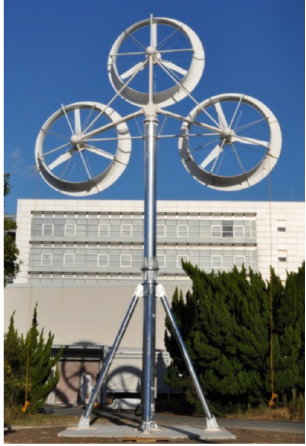
Fig. 4. 10 kW multi rotor Wind lens turbine system (3 kW (cid:1) 3) at Kyushu